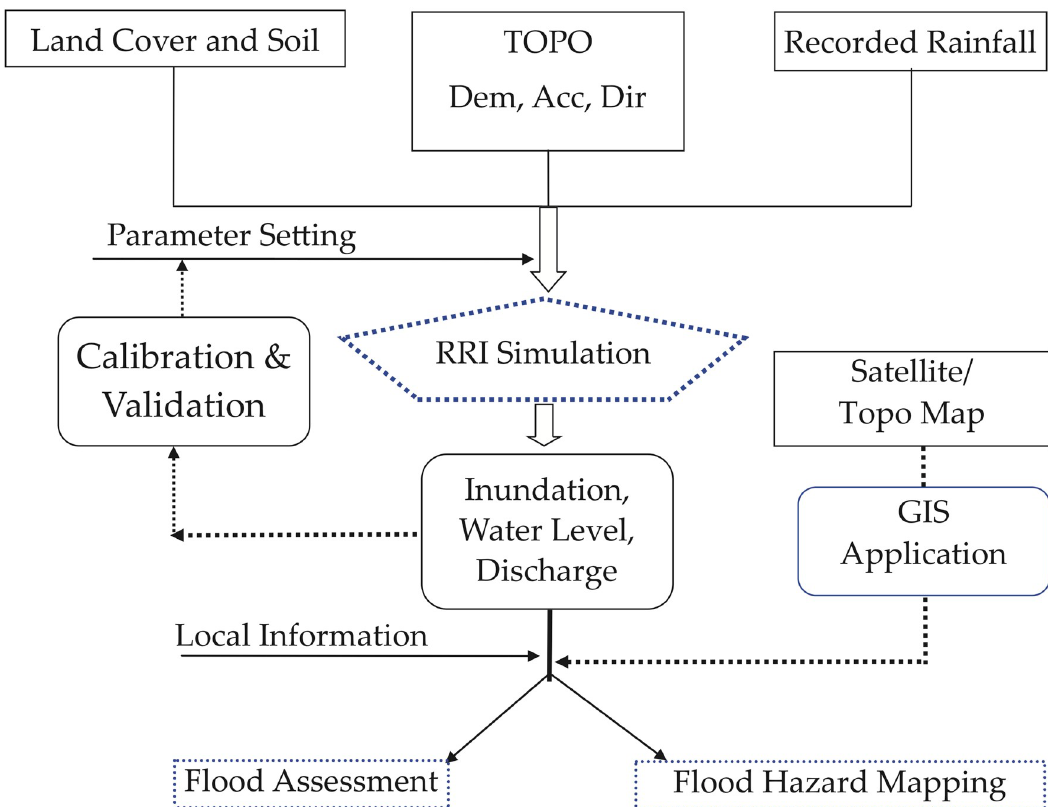
Fig 4. The flowchart of model simulation used in this